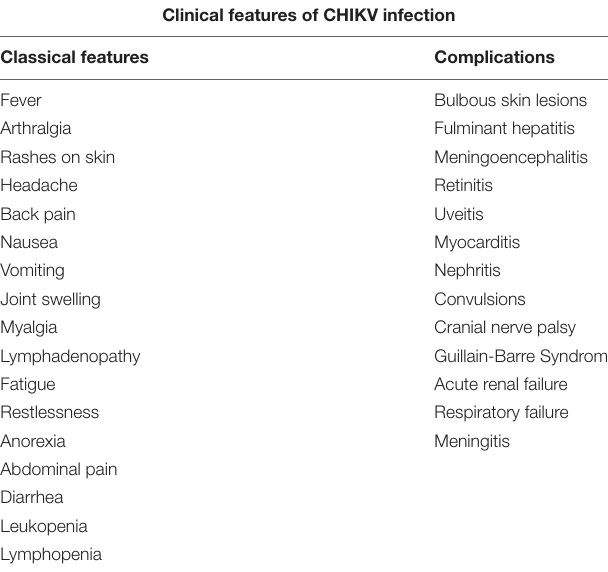
TABLE 1 | Classical and non-classical clinical manifestations in chikungunya infection. Clinical features of CHIKV infection